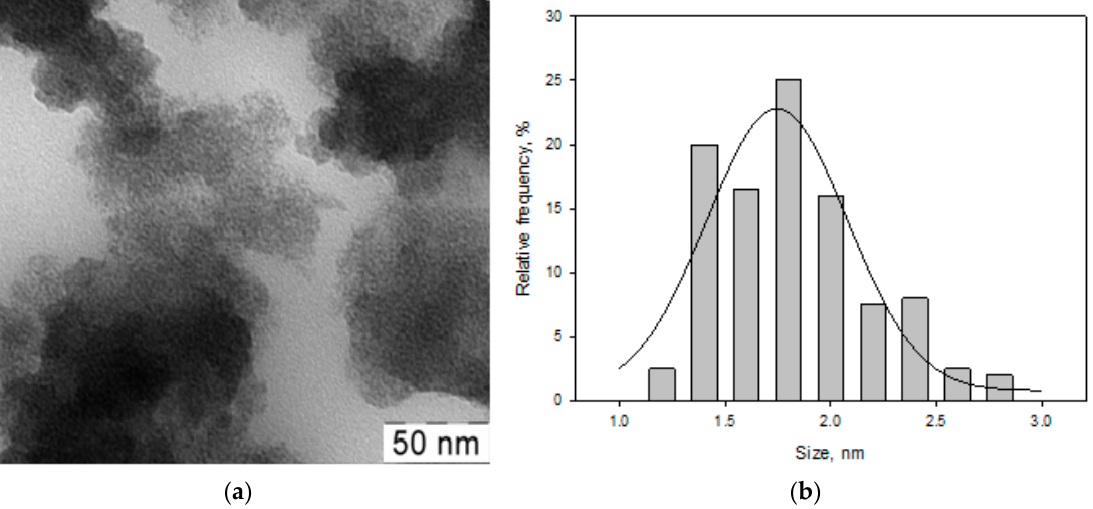
Figure 3. TEM images ( a ) and the size distribution ( b ) of Fe nanoparticles from the Fe-acetone sys- tem.